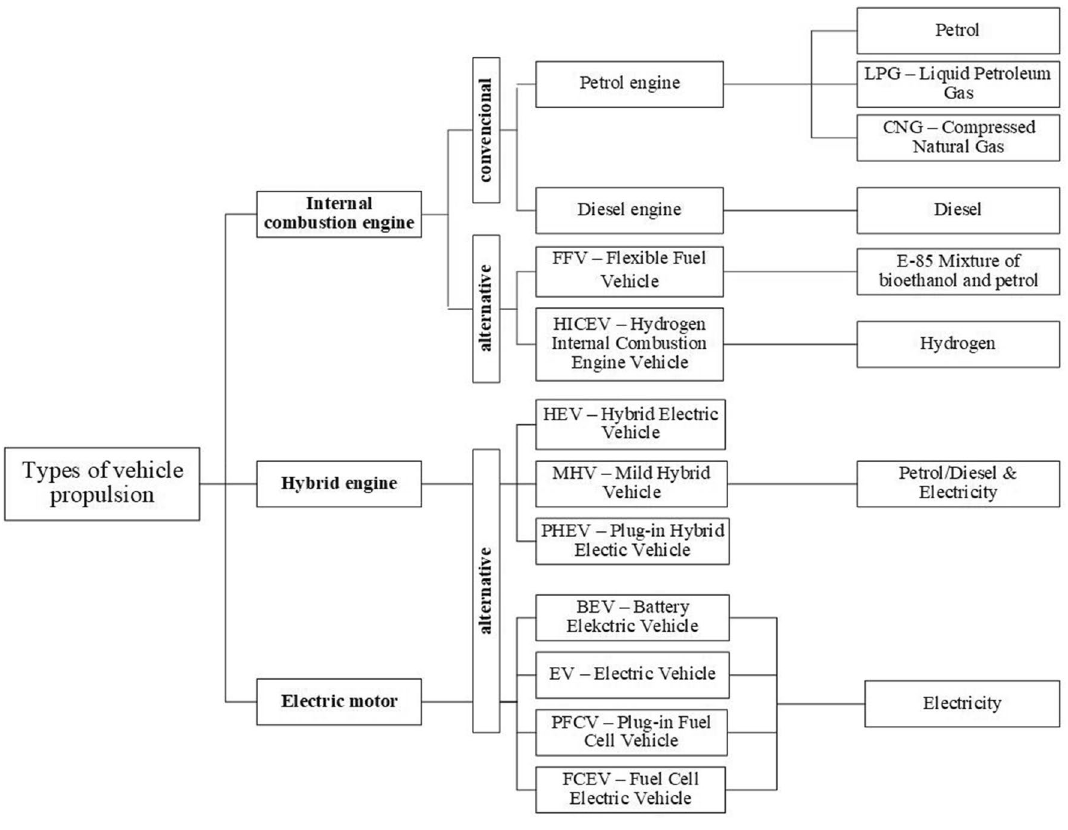
Figure 2. Overview of the passenger cars